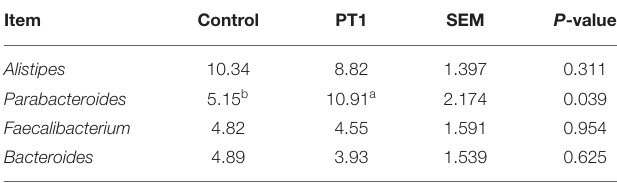
TABLE 8 | The dominant flora at the genus